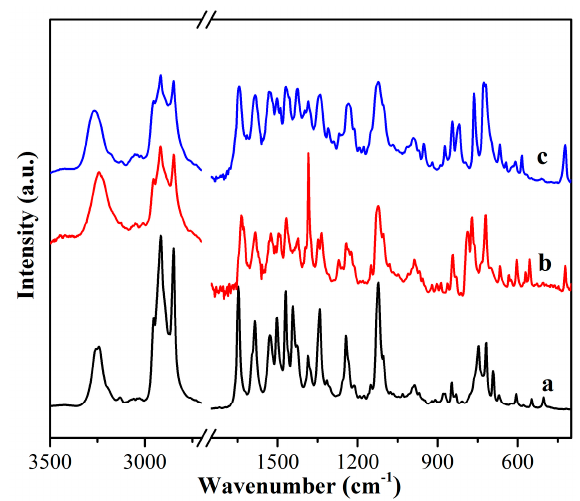
Figure 6. FT-IR spectra of xerogels from gels in n-pentanol: ( a ) TC16-Ben; ( b ) TC16-Np; ( c ) TC16-Fl.